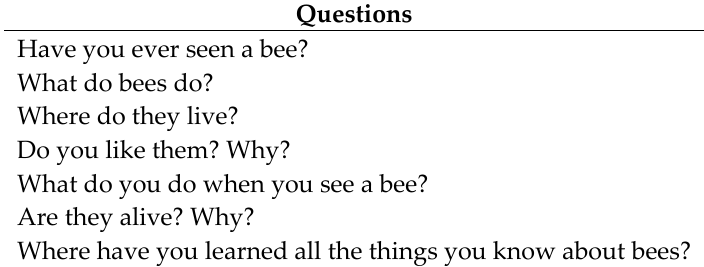
Table 1. Questions used in the semi-structured